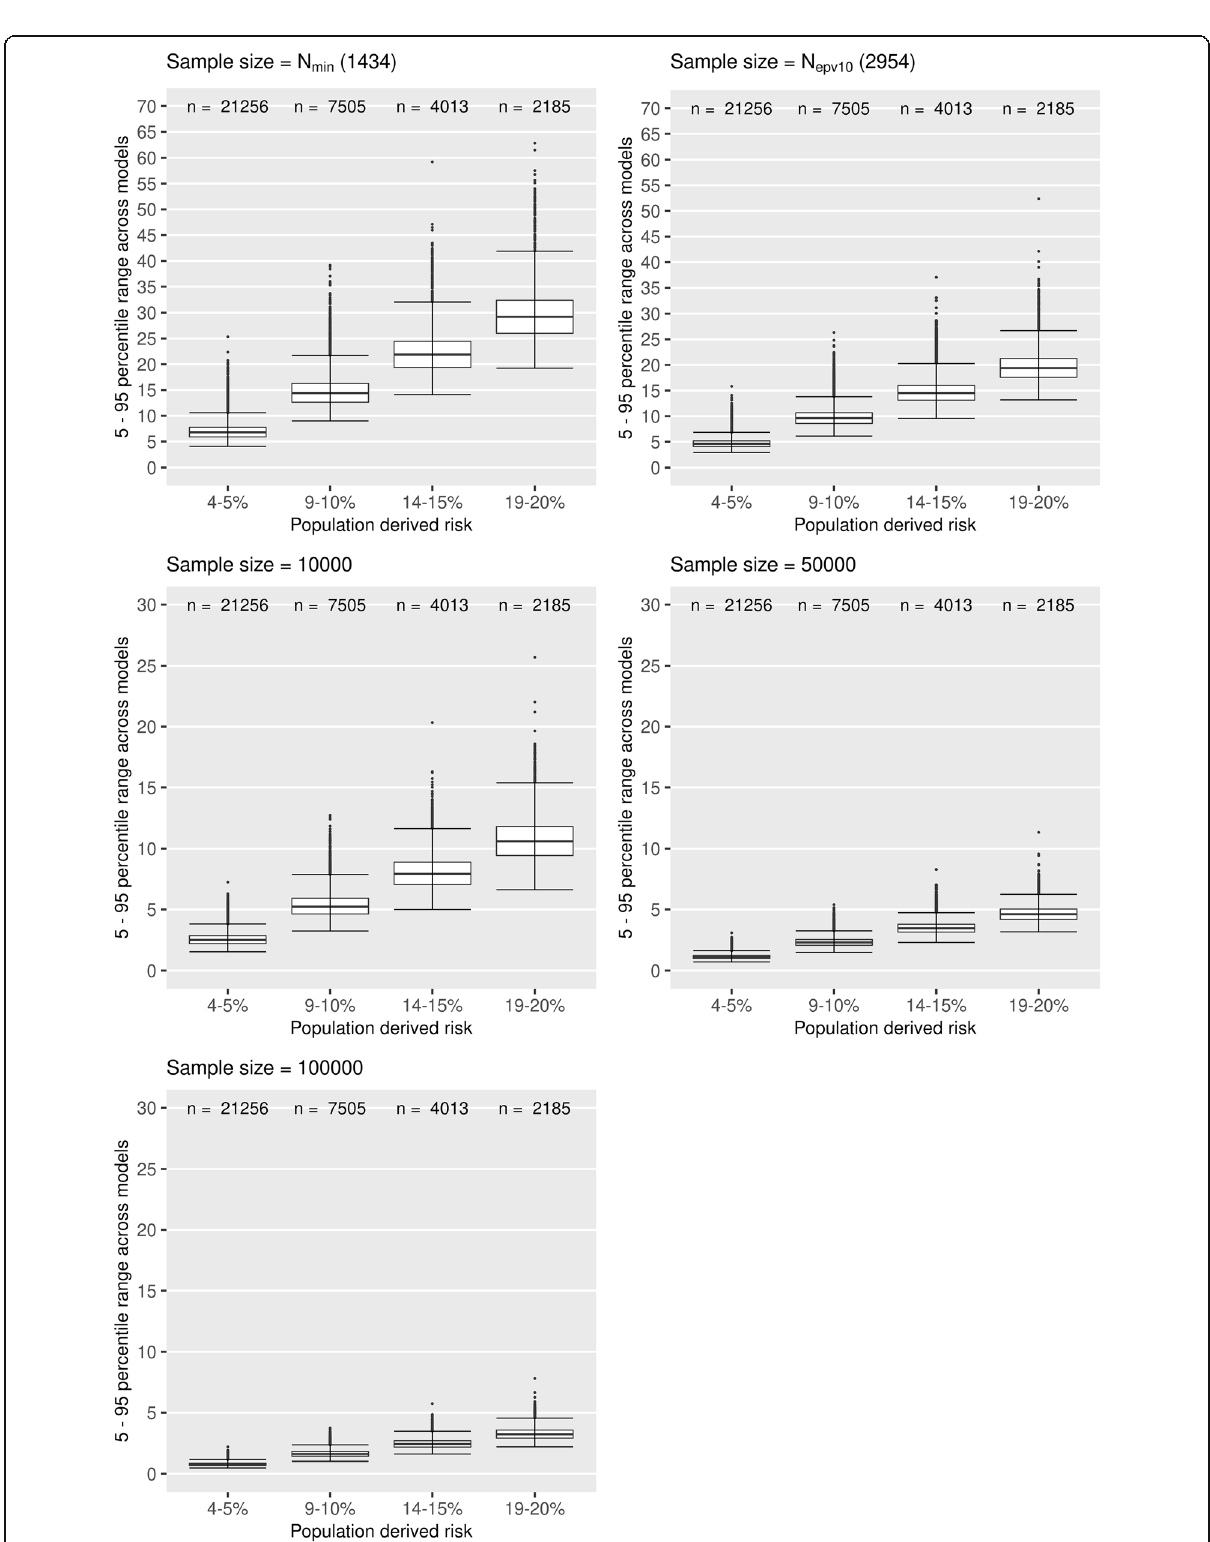
Fig. 2 Boxplots of the percentile ranges of risk for individuals across the 1000 models (female cohort). Each data point represents the 5 – 95th percentile range in risk for an individual across the 1000